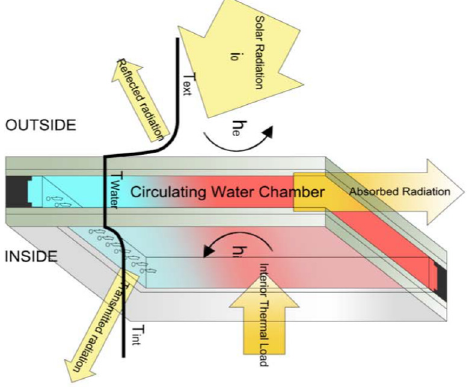
Fig. 1. Thermal performance of the WFDG system. Fig. 2. WFDG system working as an optical filter.